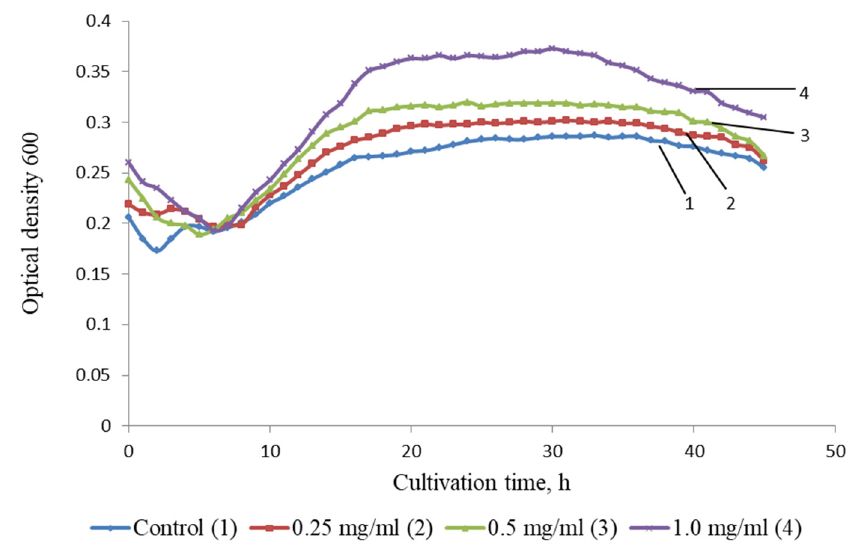
Figure 5. Growth curves of Saccharomyces cerevisiae Y-564 yeast cells with or without the Amelanchier ovalis berry extract: 0.25, 0.5, and 1 mg/mL.